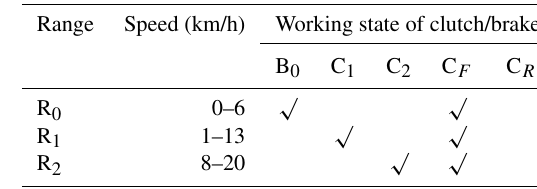
Table 1. Clutch/brake schedule of the cotton picker in the forward